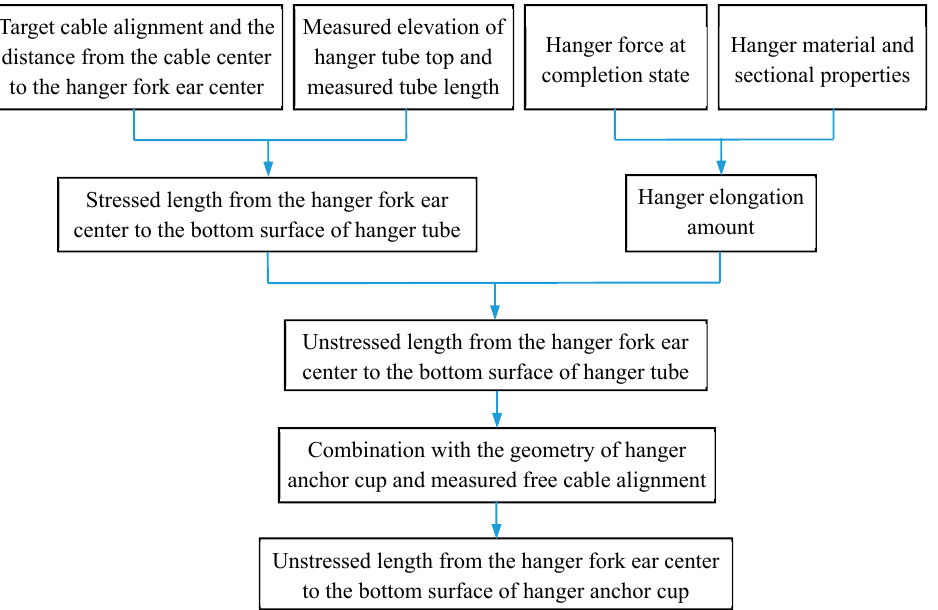
Figure 15. Algorithm flowchart of the determination method of unstressed hanger length.